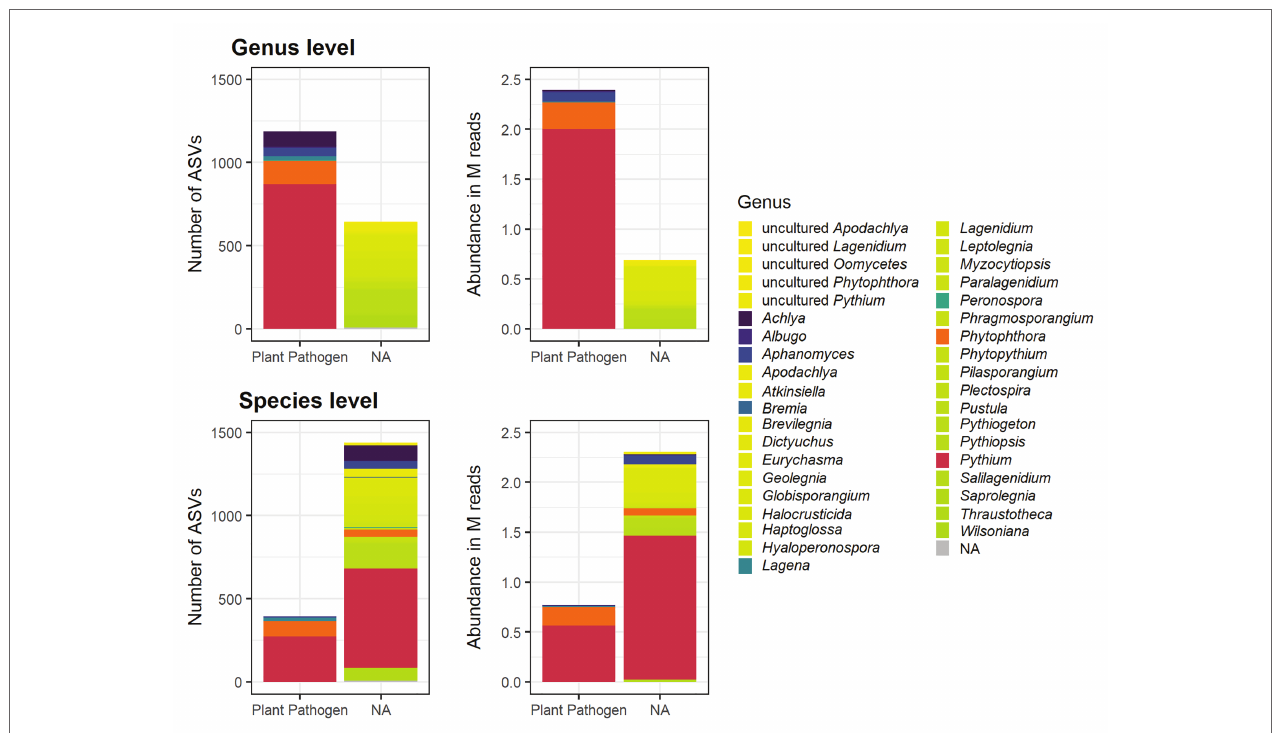
FIGURE 2 | Oomycete ASVs in rhizospheric soil samples detected by ITS metabarcoding, and their classification in the FUNGuild database on a genus and species level. The number of ASVs with a given designation is shown in the left panels and the total abundance of these ASVs in million (M) reads is shown in the right panels. In both the genus and species level plots, the bars are colored according to the genus assignment. Pythium and Phytophthora are highlighted in red and orange, respectively. Other genera that were assigned to the “plant pathogen” guild and species belonging to them are colored in shades between dark purple and dark green. Oomycete genera that were not assigned any guild in the FUNGuild database (“NA”) and the species belonging to them are colored in shades between yellow and